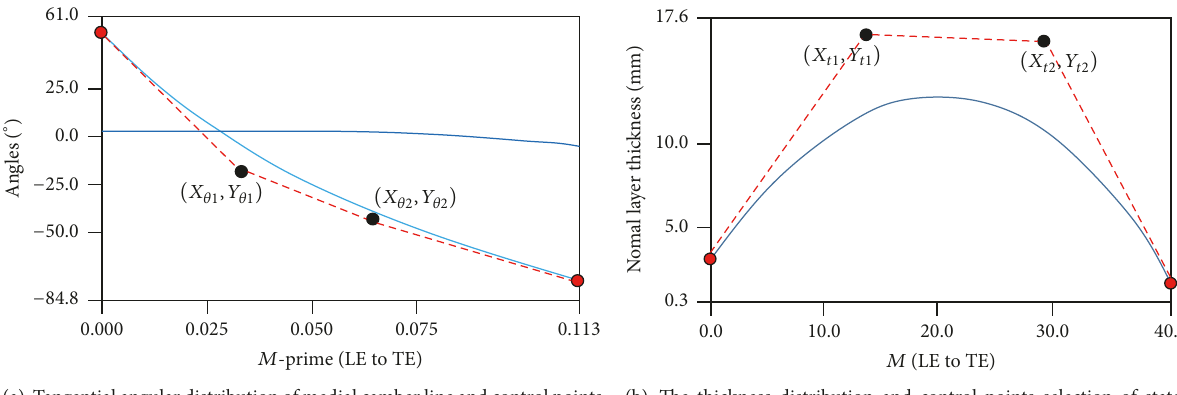
(a) Tangential angular distribution of medial camber line and control points selection of stator blade